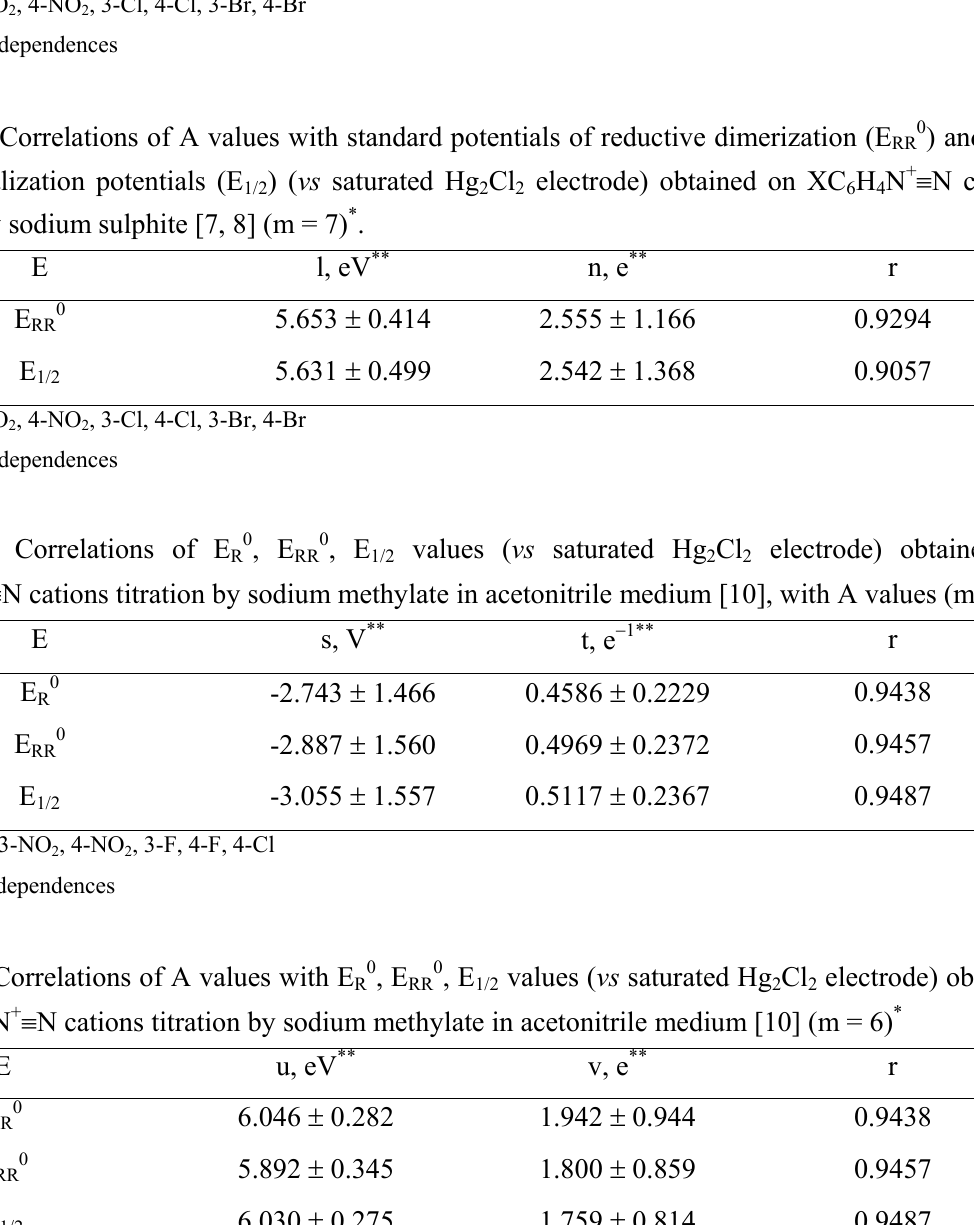
Table 1f. Correlations of A values with E R0 , E RR0 , E